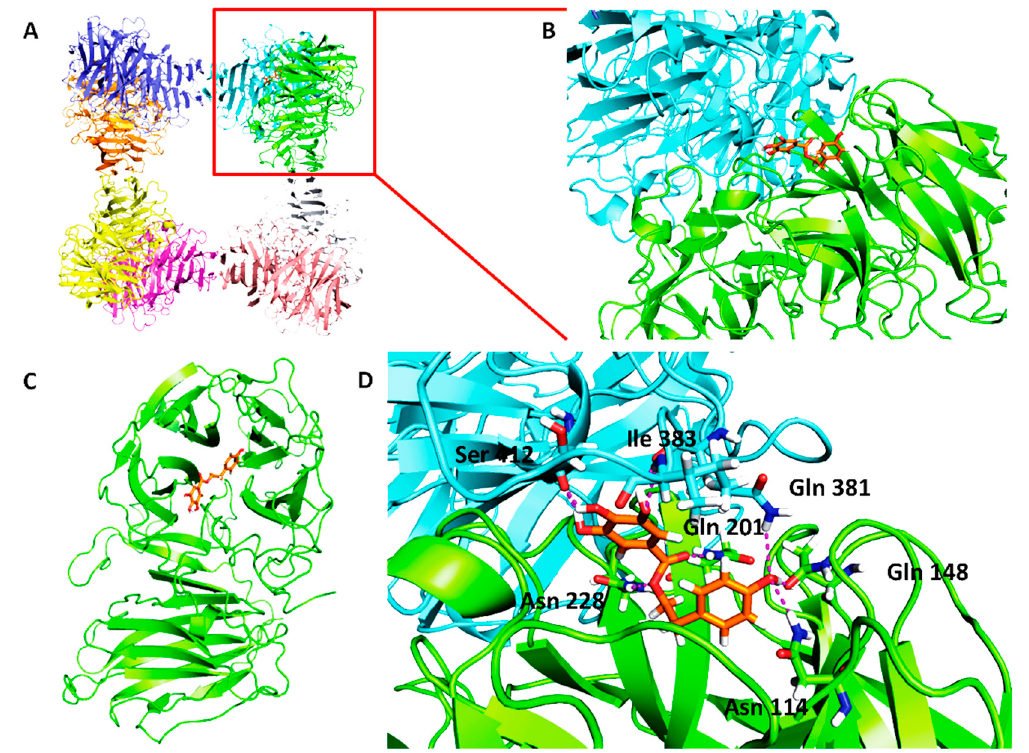
Figure 7. Proposed structural model of sucrase-HETB complex. ( A ) Oligomeric form of Saccharomyces sucrase. ( B ) Two monomers of sucrase are shown in green (monomer 1) and light blue (monomer 2). HETB is shown in orange. ( C ) Monomer 1 is shown in green and HETB is shown in orange. ( D ) Two monomers of sucrase are shown in green (monomer 1) and light blue (monomer 2). HETB is shown in orange.